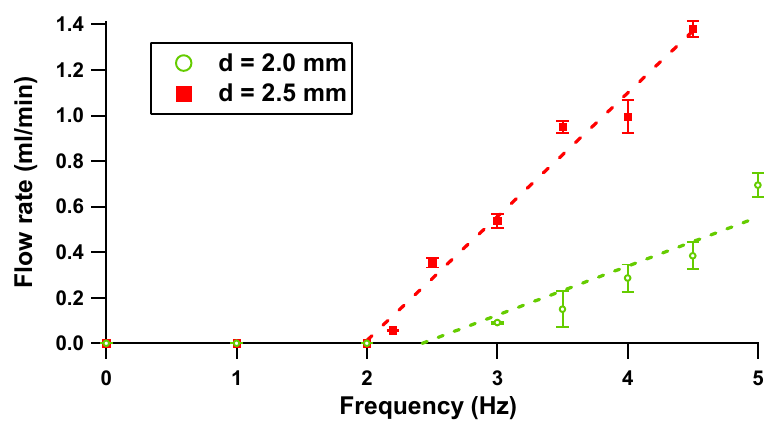
Figure 9. Flow rate vs. Frequency (0–5